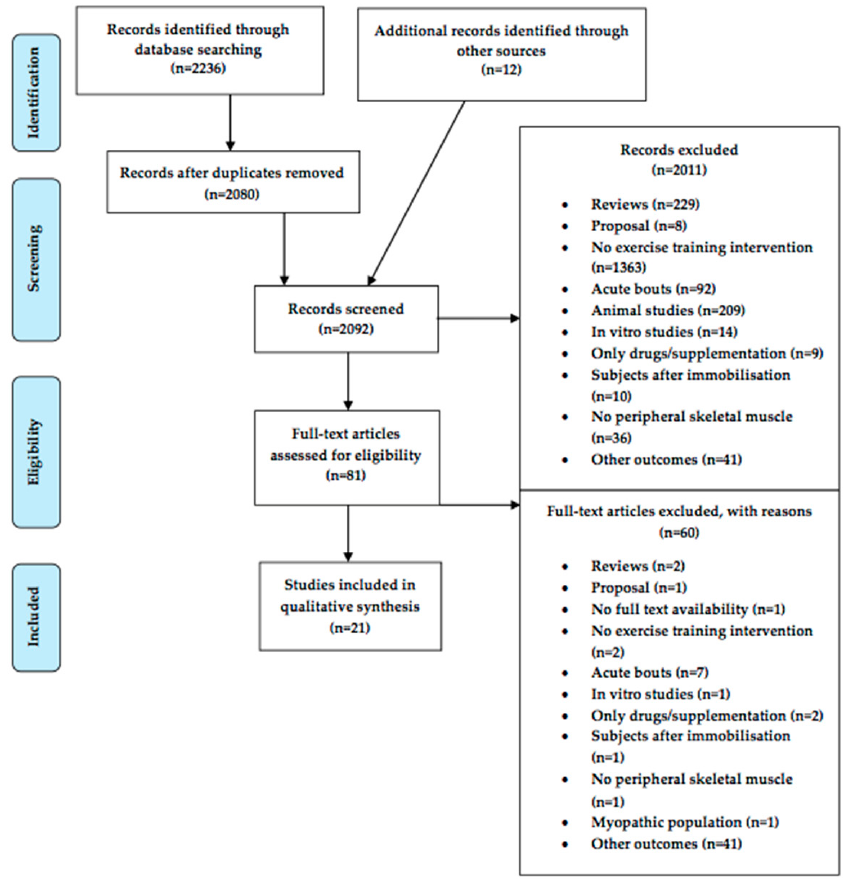
Figure 1. PRISMA flow diagram of the identification and selection